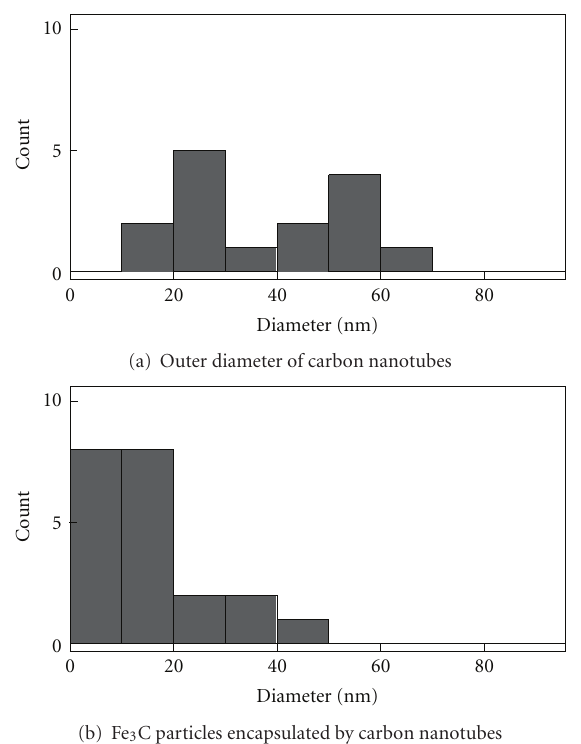
Figure 9: Histograms of outer diameter of carbon nanotubes (a) and Fe 3 C particles encapsulated by carbon nanotubes